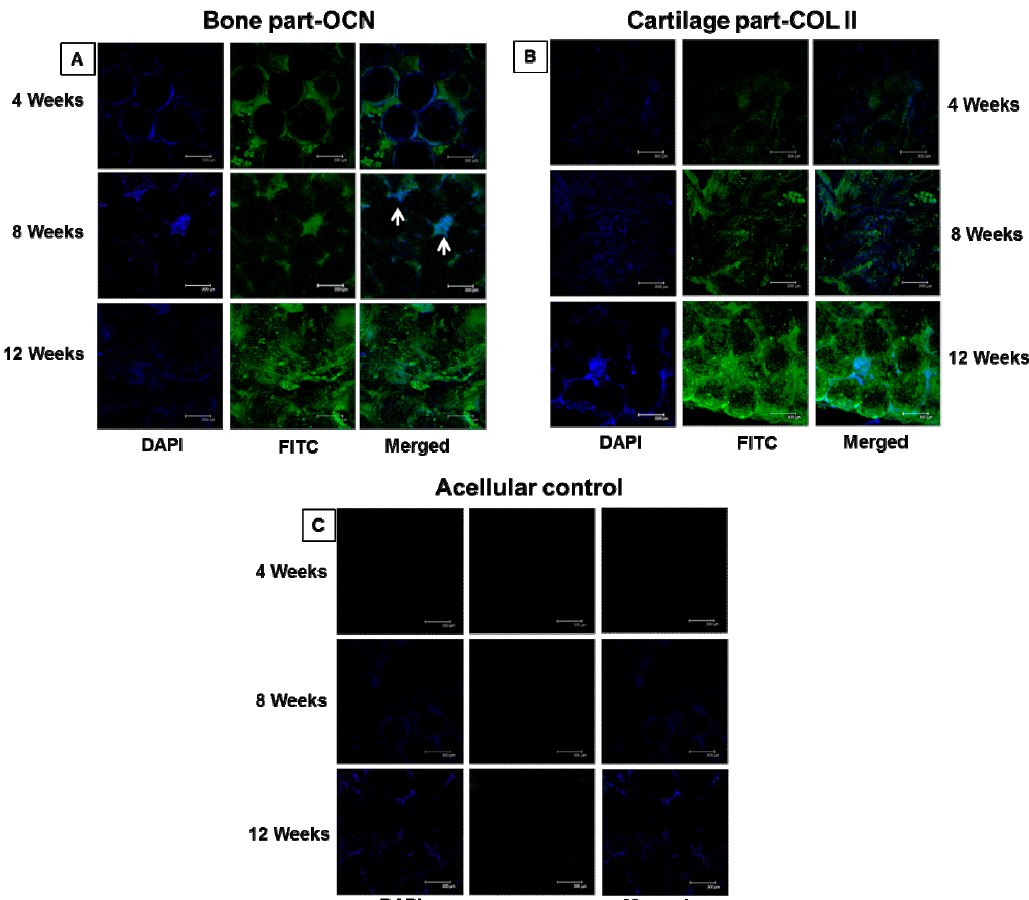
Figure 12. Immunofluorescent staining images using DAPI for cell nucleus and FITC-conjugated antibody for osteocalcin (OCN) in the bone part ( A ) and DAPI for cell nucleus and FITC-conjugated antibody for type II collagen (COL II) in the cartilage part ( B ) of cell-seeded OC scaffolds. The samples were harvested from nude mice 4, 8, and 12 weeks post-implantation. BMSCs and chondrocytes were co-cultured in the OC scaffold and bone and cartilage parts of the scaffolds were observed by confocal microscope. White arrows indicate enhanced OCN deposition into pores. The same staining results were shown for acellular controls in ( C ). Bar = 300 µm.